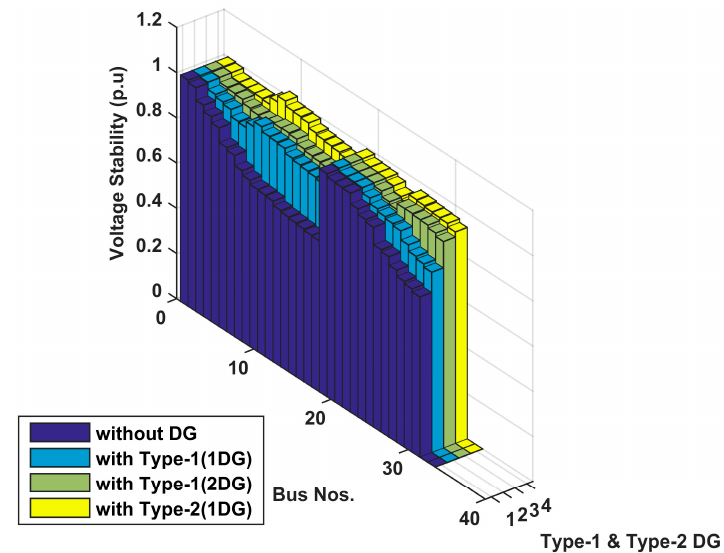
Figure 17. Voltage stability for Type-1 (1 DG and 2 DG) and Type-3 (1 DG).